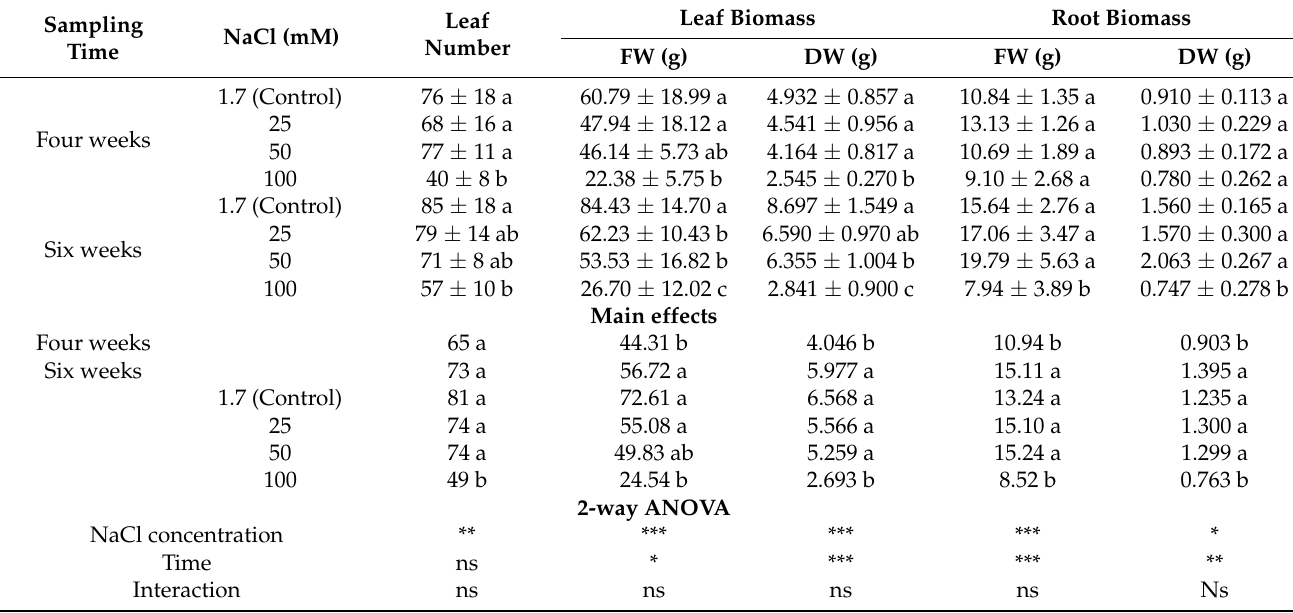
Table 1. Growth parameters for Reichardia picroides plants grown in floating system with different NaCl concentrations in the nutrient solution and sampled at four and six weeks after